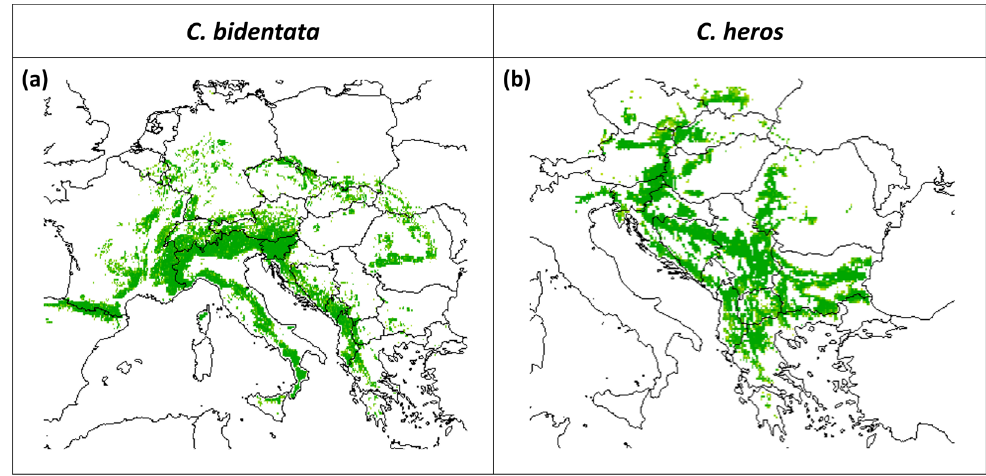
Figure 2. Predicted suitable area under current climatic conditions for ( a ) C. bidentata and ( b ) C. heros , based on the ensemble of models (scale: predicted potential suitability, green indicates the area suitable for the species).